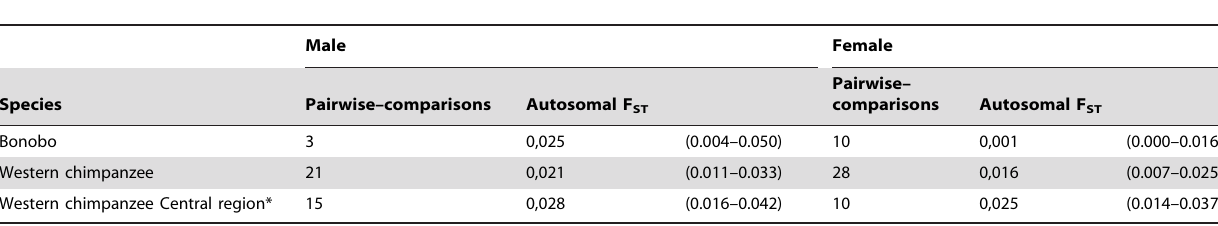
Table 1. Autosomal genetic differentiation (with 95% confidence interval) in bonobo and chimpanzee groups.